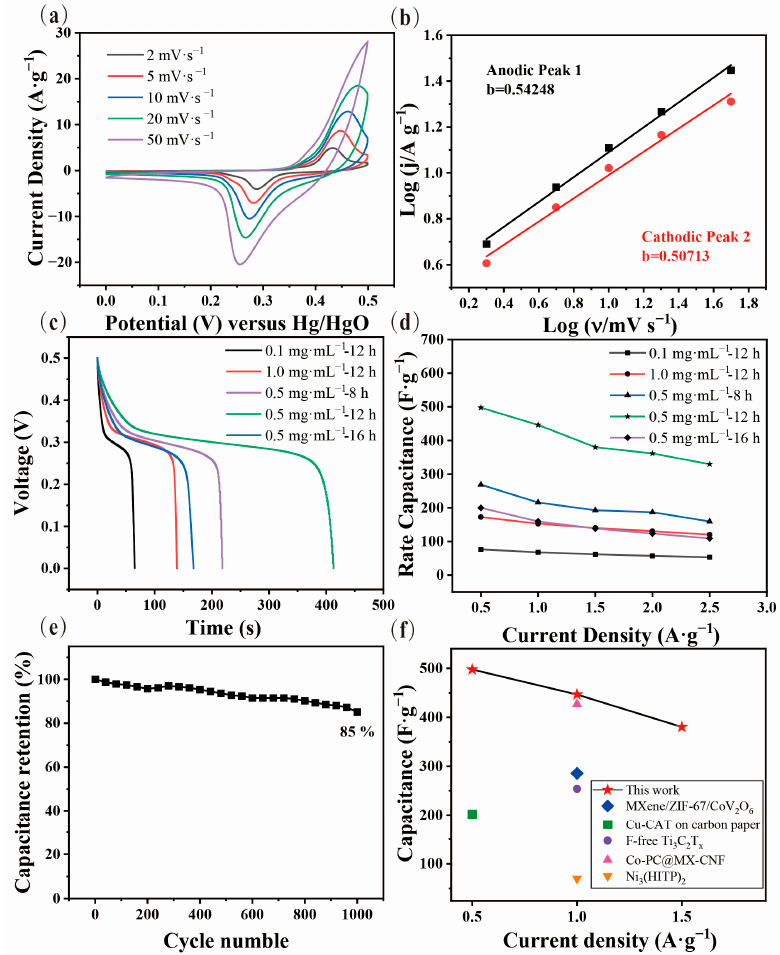
Figure 4. ( a ) CV curves of the Ni-MOF/Ti 3 C 2 T x sample prepared by growth condition of 0.5 mg · mL − 1 and 12 h; ( b ) the corresponding determination of b-values based on cathodic and anodic peaks; ( c ) GCD curves of the Ni-MOF/Ti 3 C 2 T x samples obtained by different growth conditions; ( d ) the comparation of rate capacitance between Ni-MOF/Ti 3 C 2 T x products with different growth conditions; ( e ) cycling behaviors of the Ni-MOF/Ti 3 C 2 T x sample of 0.5 mg · mL − 1 and 12 h growth conditions; and ( f ) ragone plots of the Ni-MOF/Ti 3 C 2 T x sample compared with previous studies [17,38,47–49].